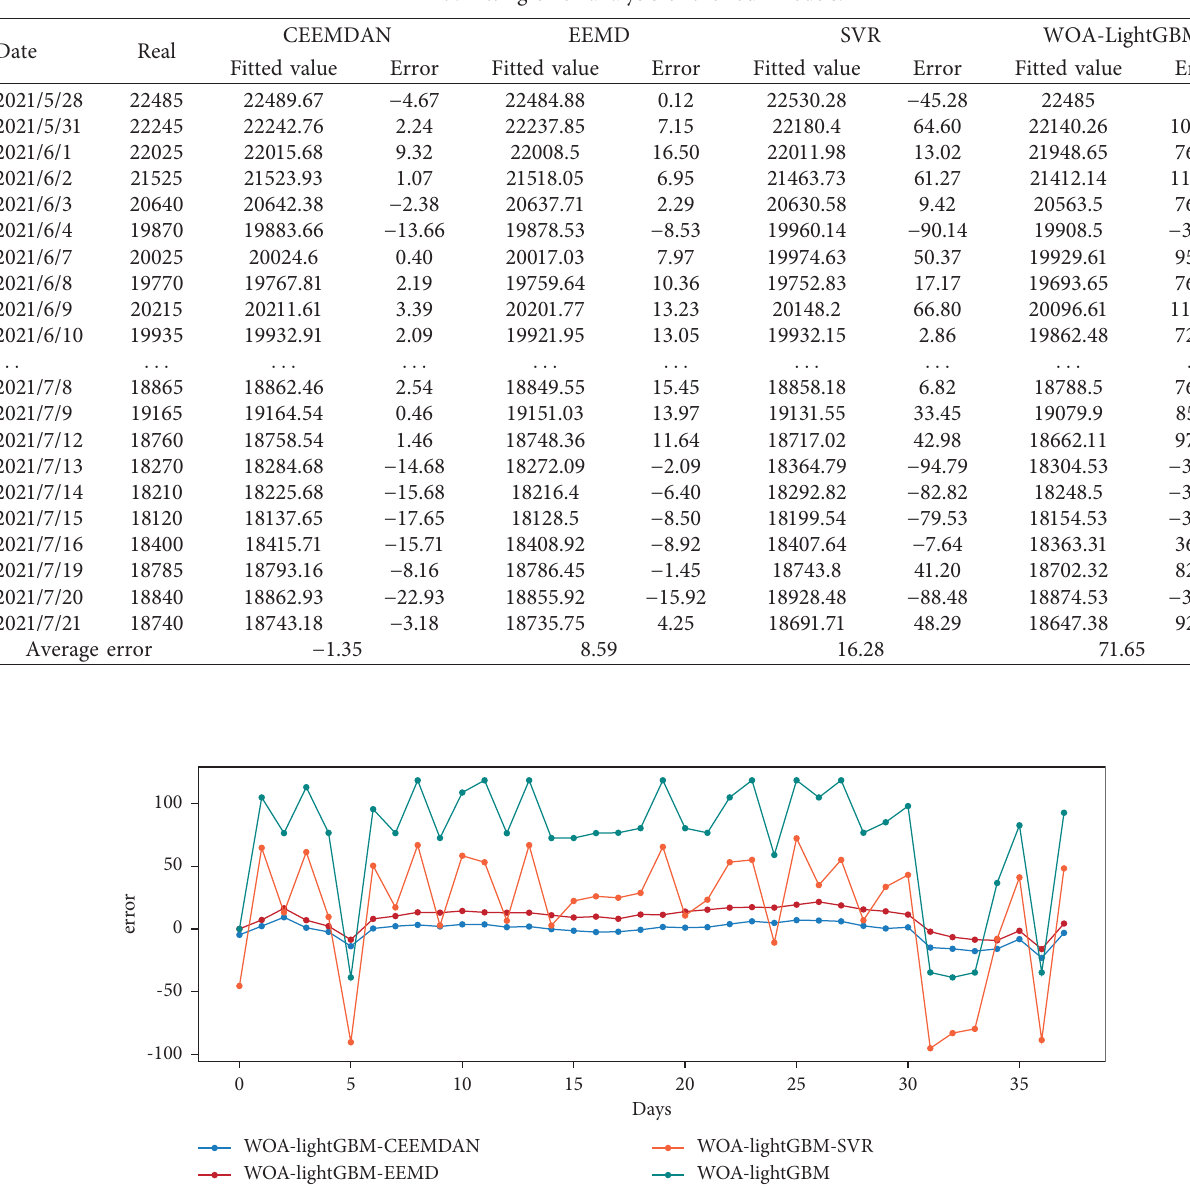
Table 7: Fitting error analysis of the four models.